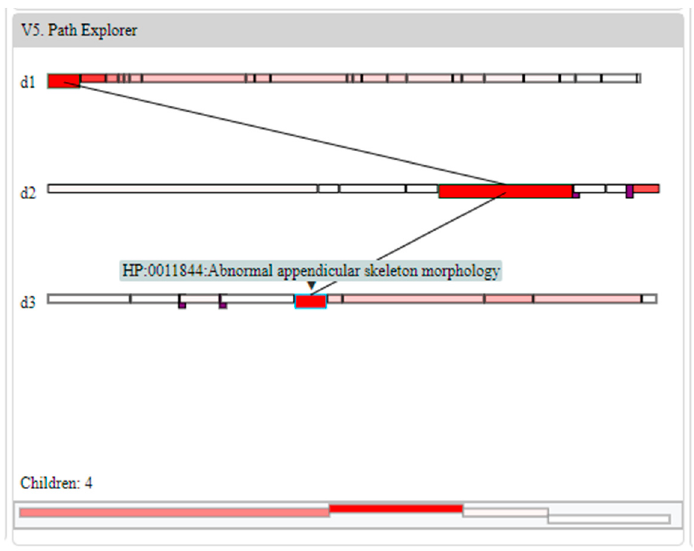
Figure 32. The Path Explorer Panel subview after selecting “Abnormal Appendicular Skeleton Morphology” as its current position.